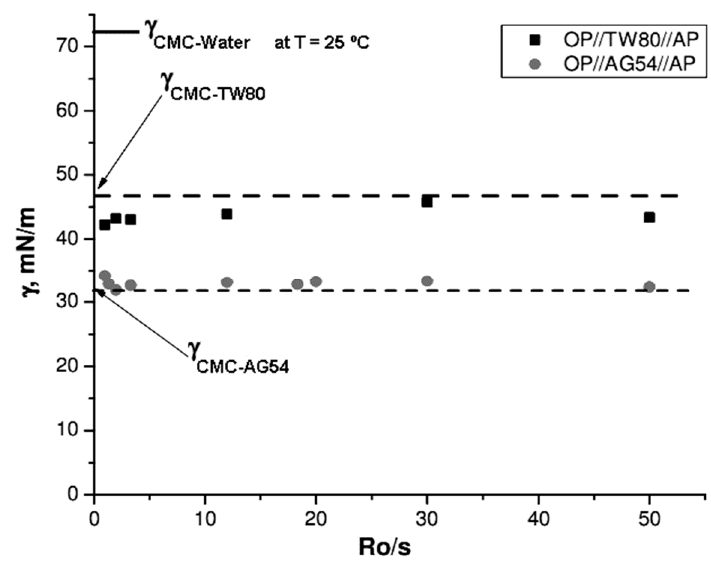
Figure 8. Surface tension of the NE as a function of AP % for the OP//TW80//AP and OP//AG54//AP systems at T = 25 °C.